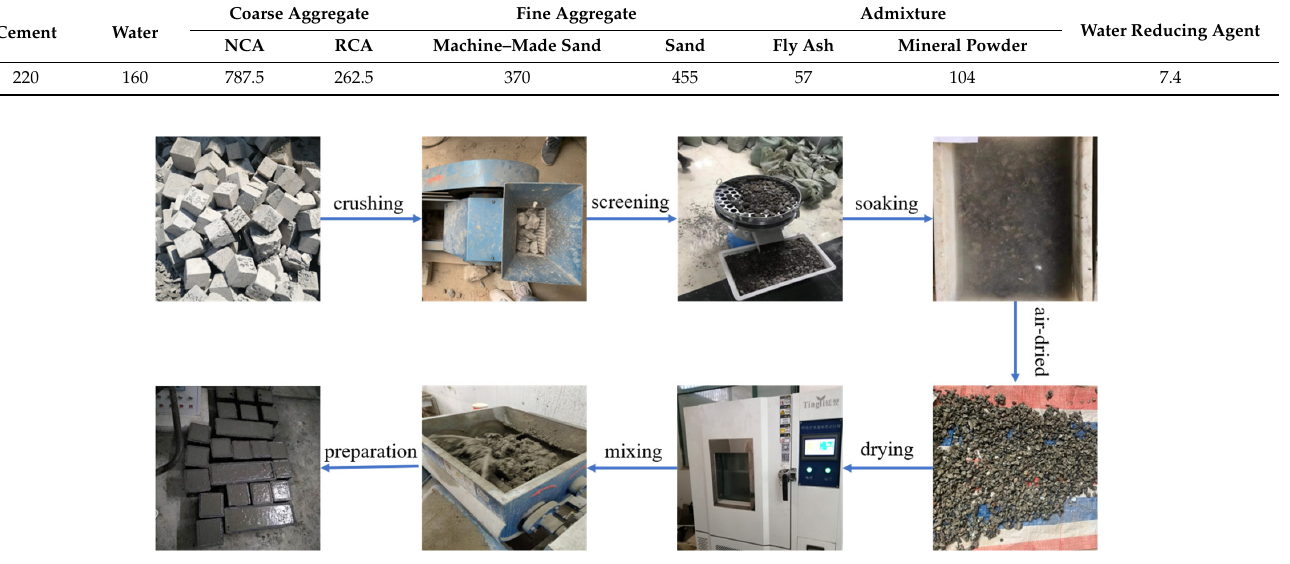
Figure 4. Preparation of concrete.